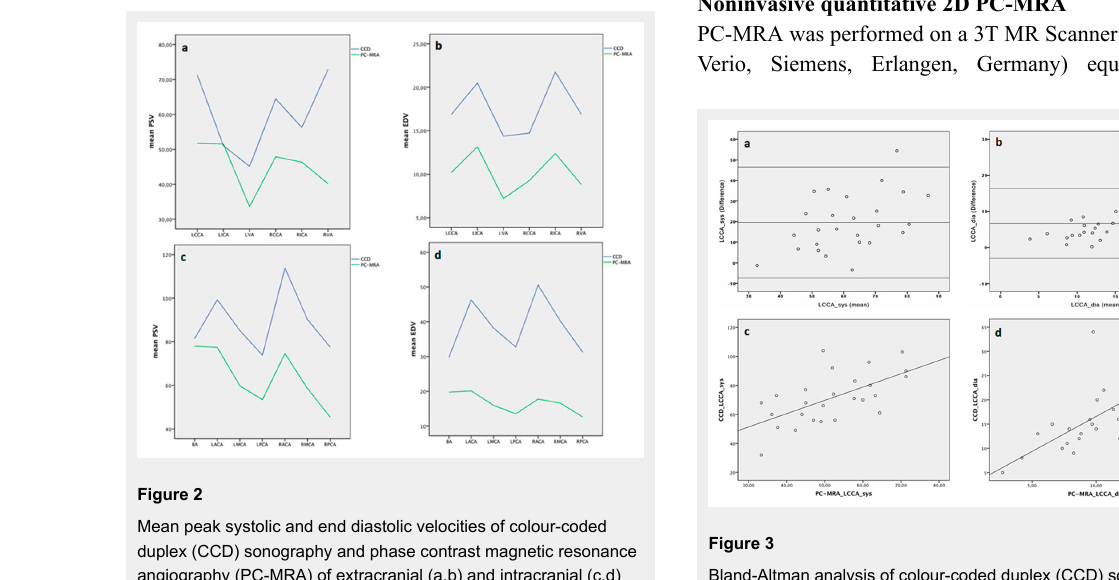
Bland-Altman analysis of colour-coded duplex (CCD) sonography compared with phase contrast magnetic resonance angiography (PC-MRA) of the left common carotid artery (LCCA) showed 25 of 26 points within 1.96 standard deviations for peak systolic velocity (PSV) (a) with a bias of 19.55 and 1.96 SD limits of agreement of –7.44 and 46.54 and for end diastolic velocity (EDV) (b) with a bias of 6.68 and 1.96 SD limits of agreement of –3.00 and 16.36. The Spearman’s r for PSV was 0.598 (c) and for EDV was 0.777 (d), both significant at the 5%